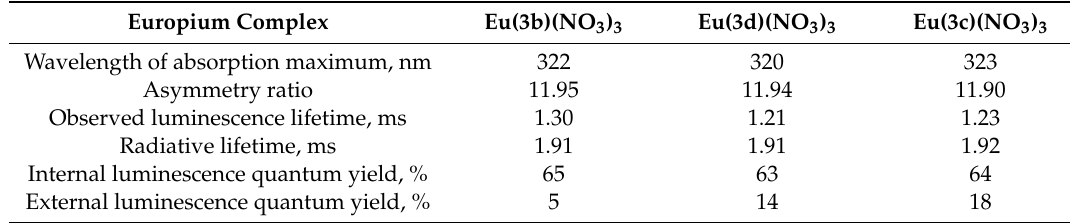
Table 5. Luminescent characteristics of europium